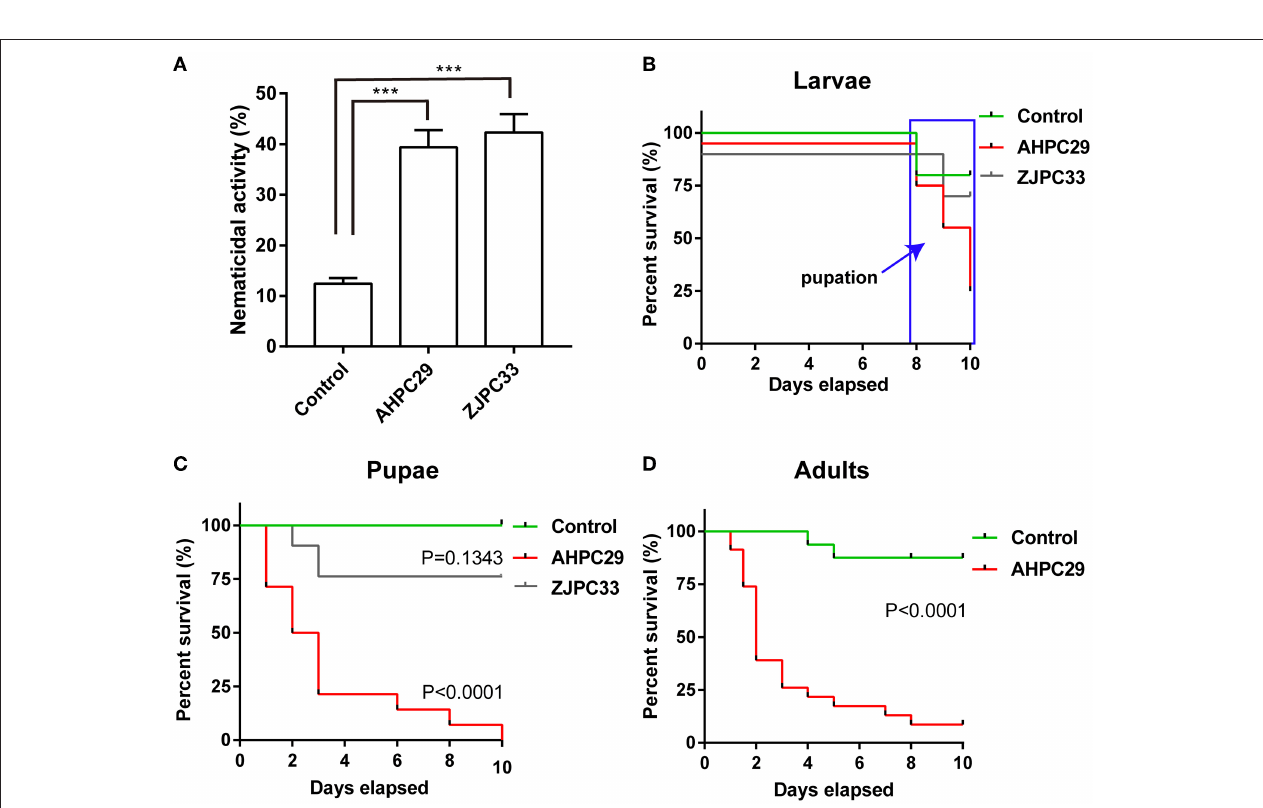
FIGURE 5 | Pathogenicity of Serratia marcescens strain to PWN and its vector beetle. (A) The mortality assay of PWN with two Serratia strains AHPC29 and ZJPC33. AHPC29: Serratia marcescens strain AHPC29; ZJC33: Serratia nematodiphila strain ZJPC33. Nematicidal activity of bacterial solution monitored after 24h. Two-tailed paired t -test, *** p < 0.001. (B,C) Meier survival curves of vector beetle last-instar larvae and pupae exposed to AHPC29 and ZJPC33. (D) Meier survival curves of vector beetle adults exposed to AHPC29. Survivorship was monitored daily for 10 days. The log-rank test was used for the comparison of survival curves.